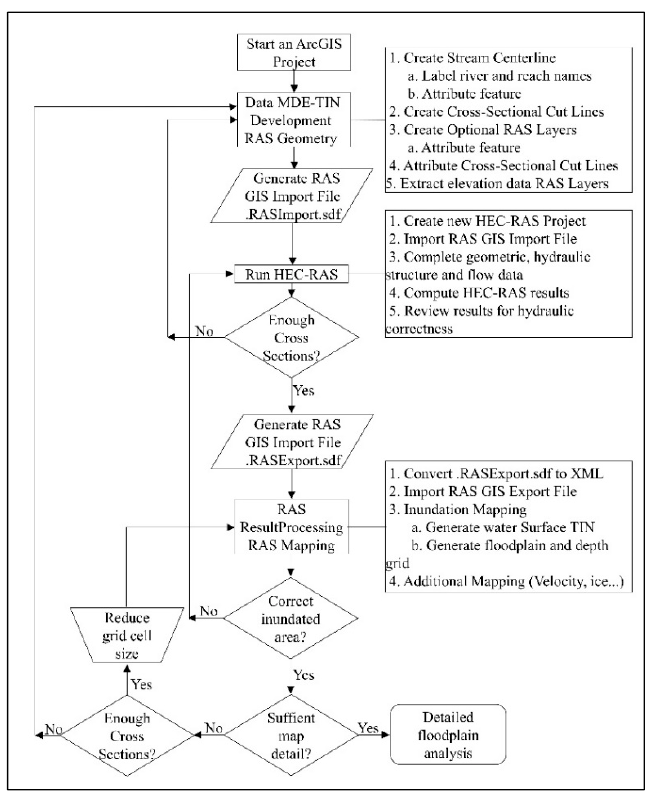
Figure 2. Hydraulic Engineering Center (HEC) GeoRAS-GIS and HEC-RAS flowchart to determine the geometrical parameters and the flood areas from hydraulic modeling.